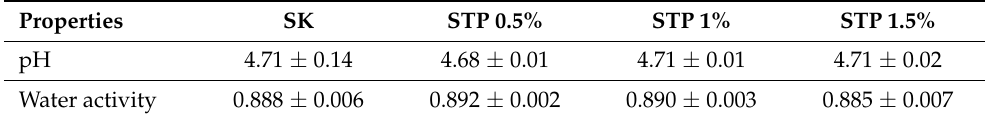
Table 3. pH and water activity of dry fermented